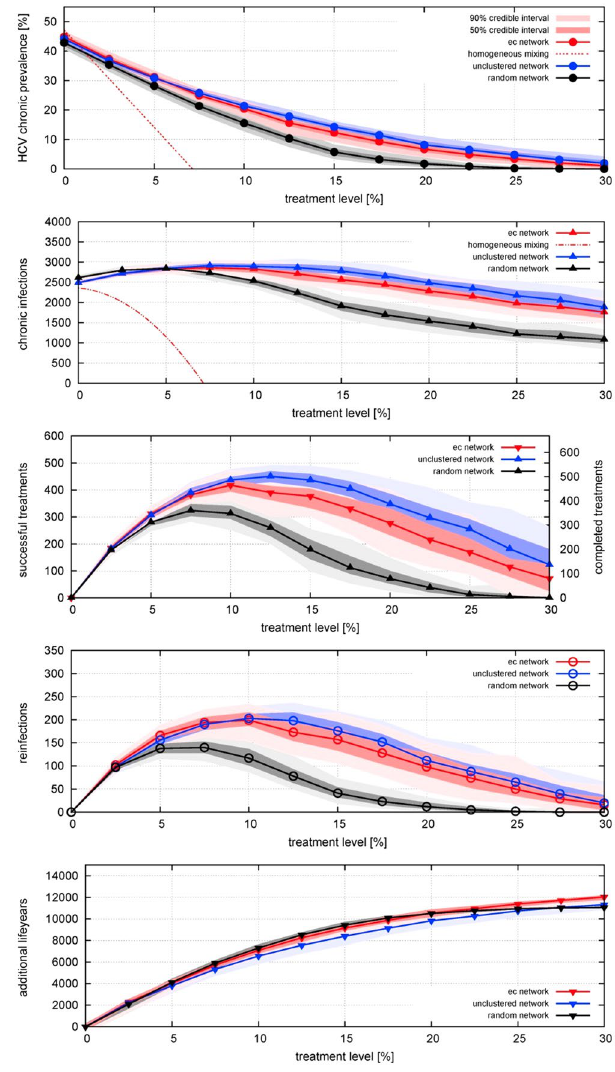
Figure 2. Effect of different treatment rates on equilibrium ( A ) prevalence of HCV infection; incidence per year of ( B ) chronic infection (including arising from reinfection), ( C ) cured by successful treatment, ( D ) reinfection; and ( E ) life-years gained; for three different network structures, for treatment rates varied from 0 to 30% per year, in the absence of behaviour-change post-treatment. Points indicate median results and shading represents the 50% range (i.e. inter-quartile range) and 90% ranges of 100 simulations of a network with 1000 PWID over a time period of 20 years (i.e. turnover of 50 people entering and exiting per year). For prevalence and incidence, the behaviour of the homogeneous-mixing model is also shown: as it is a deterministic model there is no range of